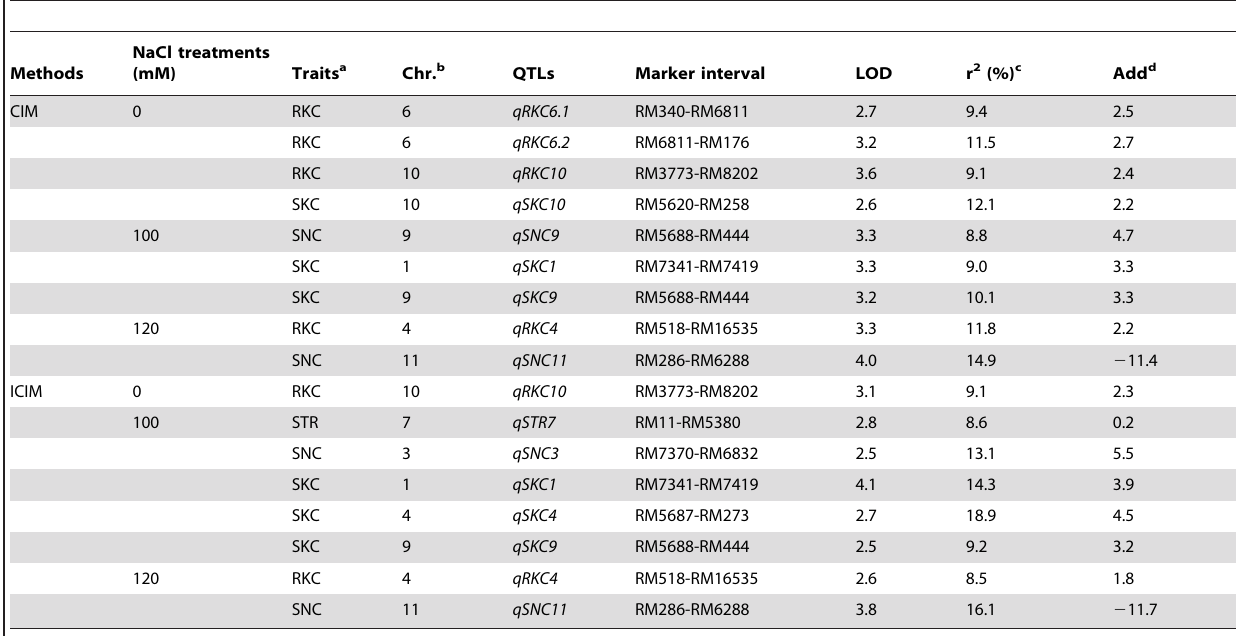
Table 3. Putative additive QTLs for relevant traits in RIL population (Jiucaiqing/IR26) under different NaCl conditions by CIM and